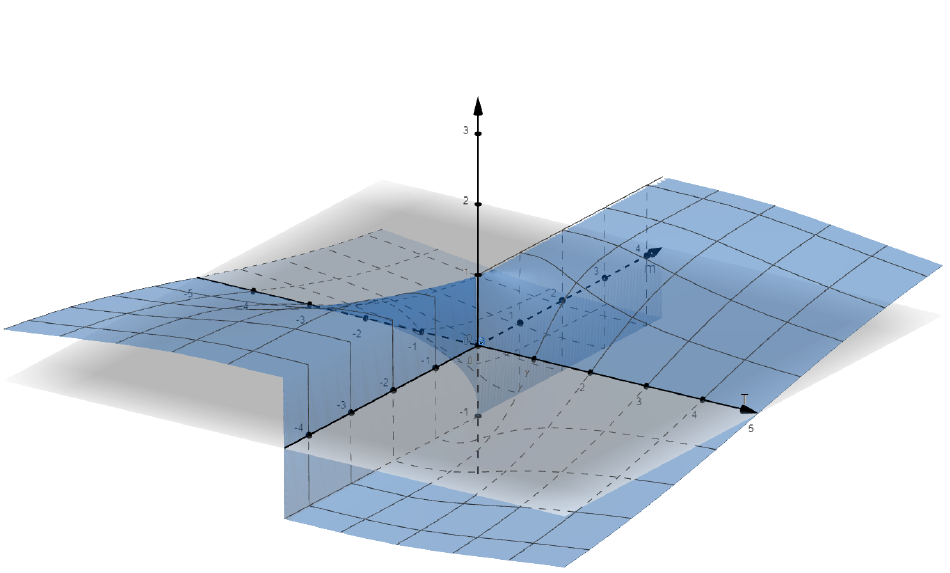
Figure 1: The magnetisation function of the Ising model. The surface (cid:128) T (cid:138) c m f ( T , m ) = tanh is plotted here for x = T and y = m . An interactive version T